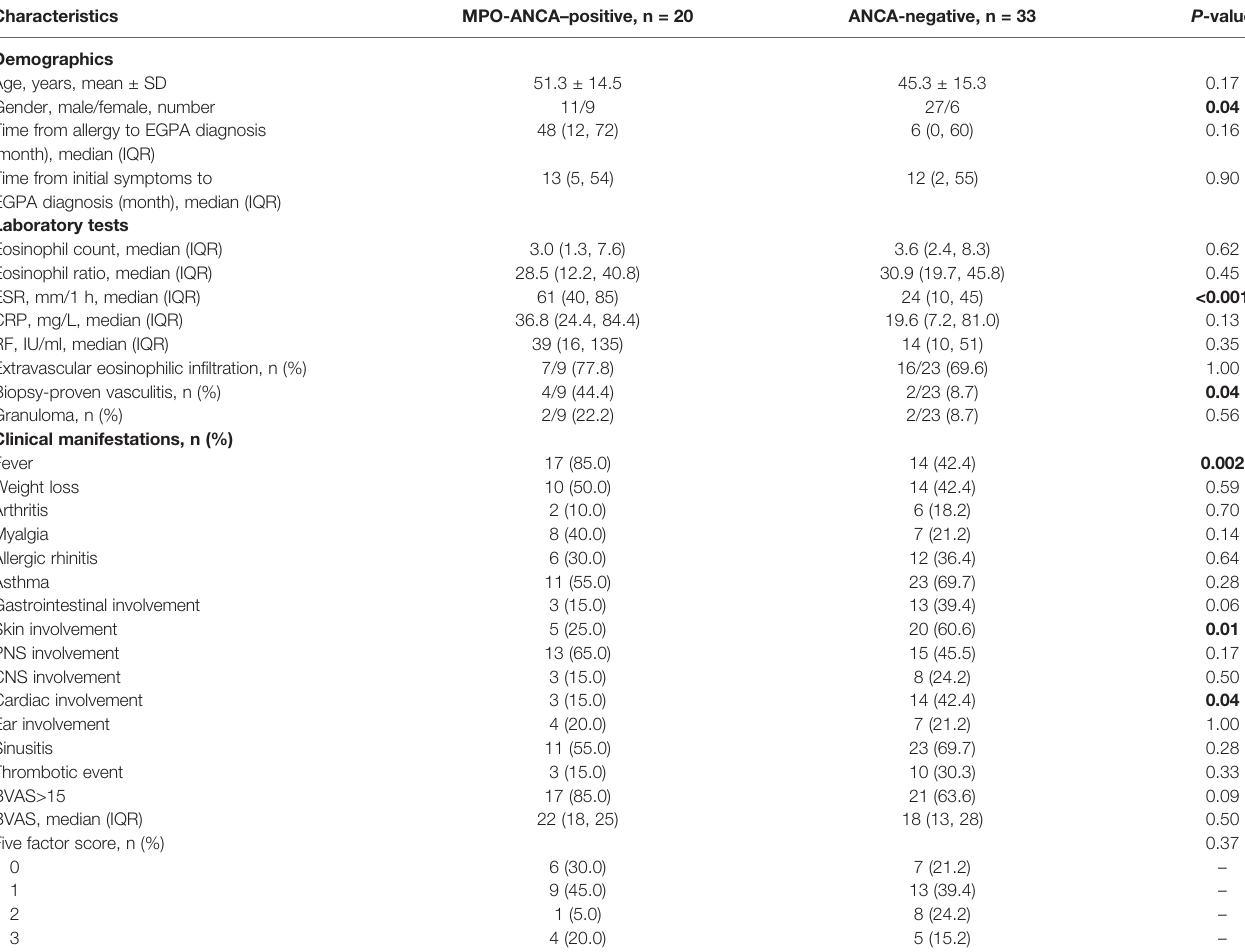
TABLE 2 | Clinical characteristics of patients with EGPA with renal involvement at baseline.